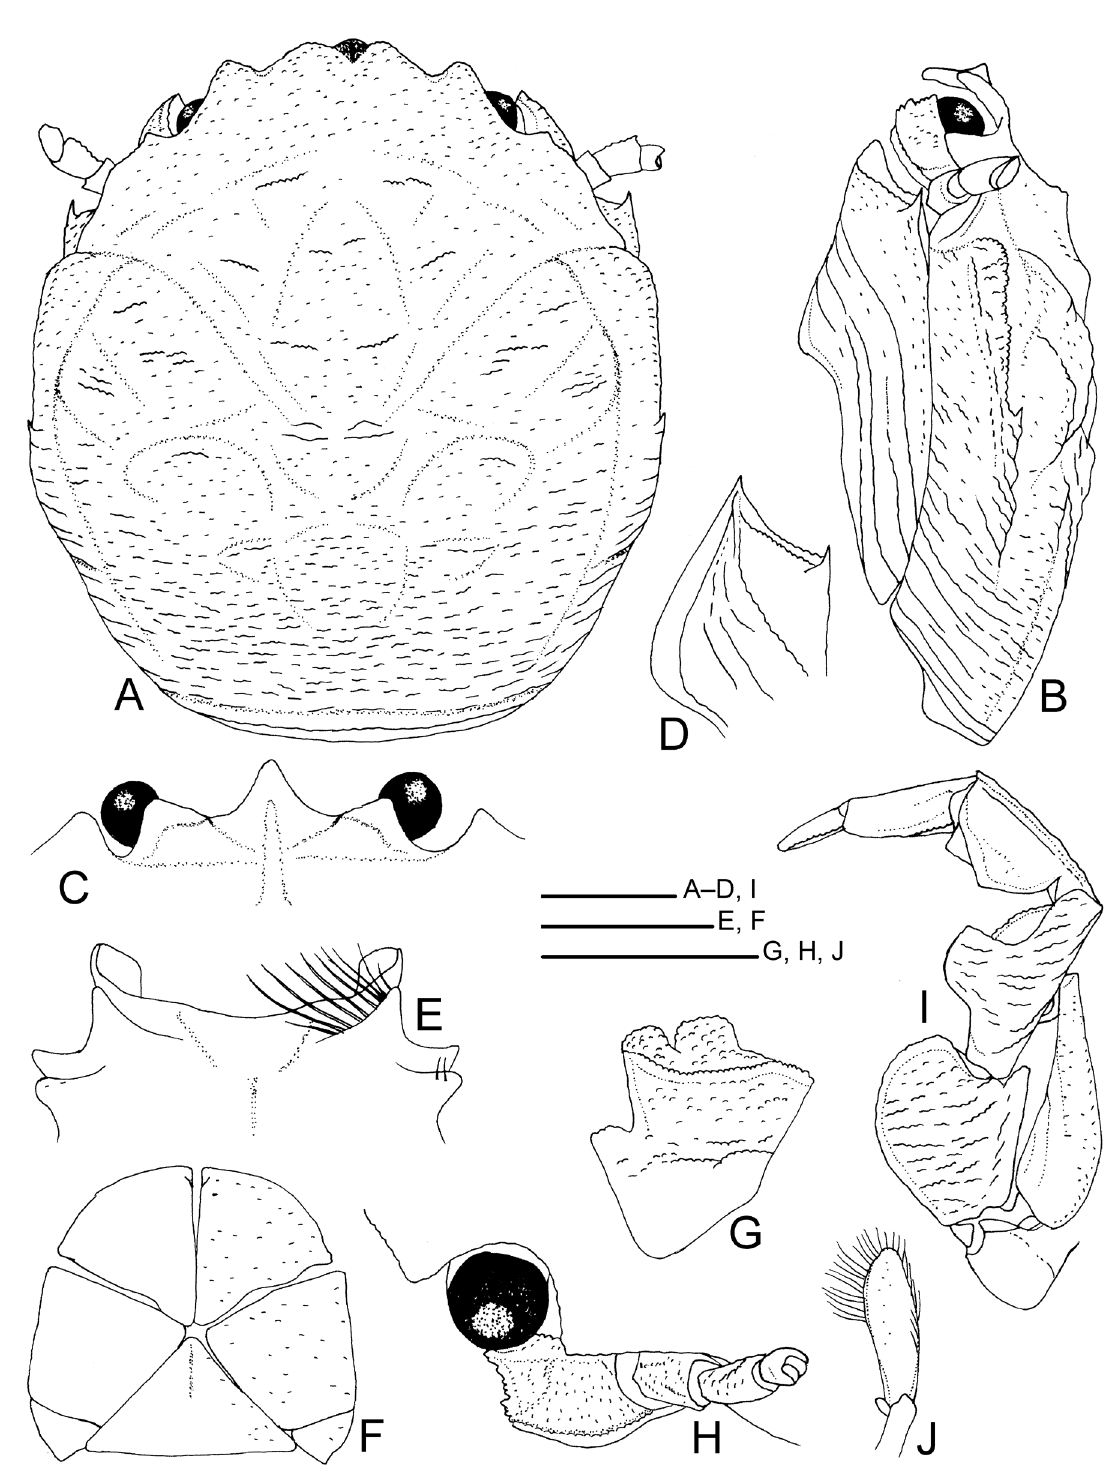
Figure 2. Enosteoides turkayi n. sp. Holotype, female (cl 4.5 mm), NMCR, Balicasag Island (A–I); paratype, male (cl 4.5 mm), ZRC 2016.0061, Balicasag Island, stn B23 (J). A, carapace, pterygostomial flap, and ocular and antennal peduncles, dorsal view; B, same, left side, lateral view; C, rostrum, and ocular peduncles, frontal view; D, anterior part of left pterygostomial flap, ventrolateral view; E, third and fourth thoracic sternites, ventral view (setae omitted from right side); F, telson, external view (surface structure omitted from right side); G, basal article of left antennular peduncle, ventral view; H, left anterior part of carapace and ocular and antennal peduncles, anterolateral view; I, left third maxilliped, lateral view (long setae on ventral margin omitted); J, right second pleopod (gonopod), ventral (posterior) view. Scale bars = 1.0